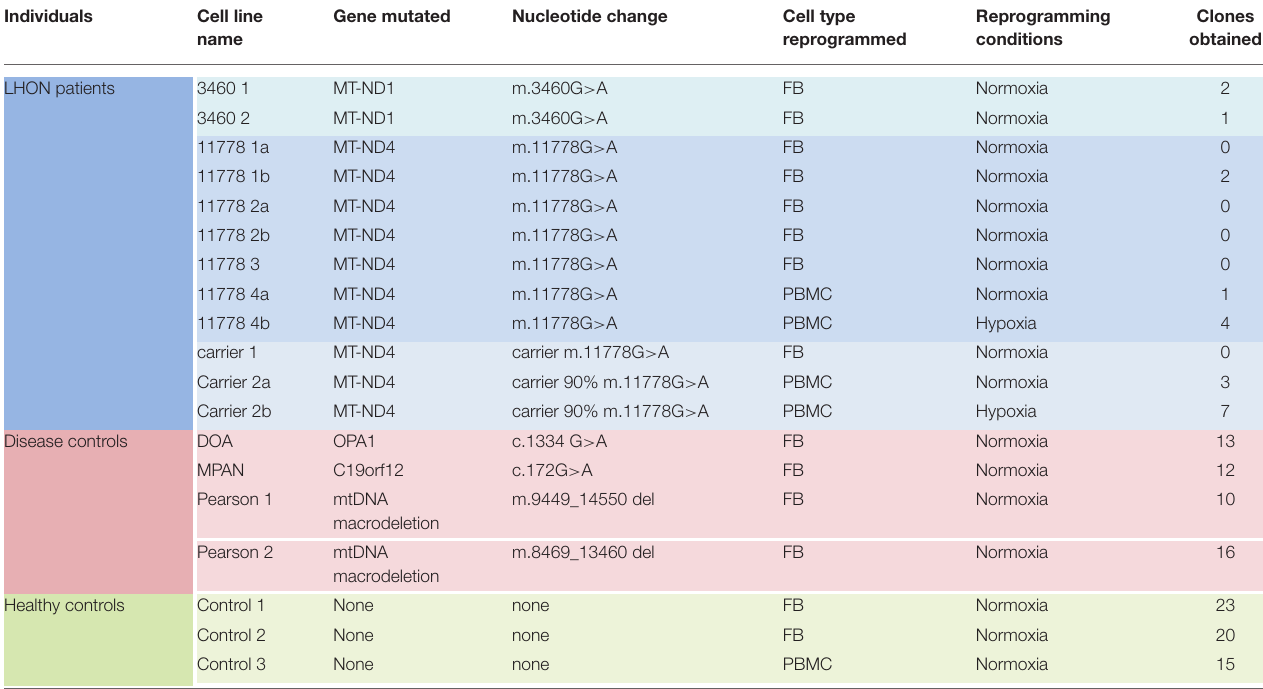
TABLE 1 | Characteristics of cell lines subjected to